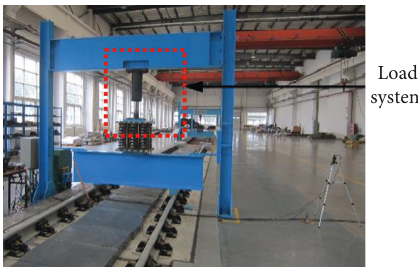
Figure 11: Quasi-static loading system.